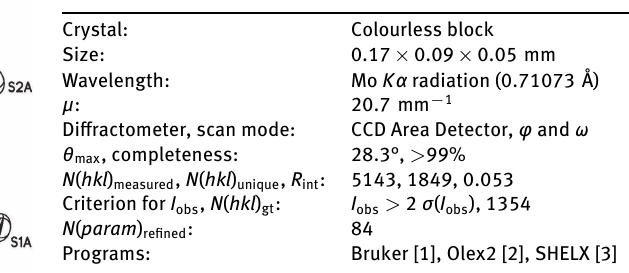
Table 1: Data collection and handling.